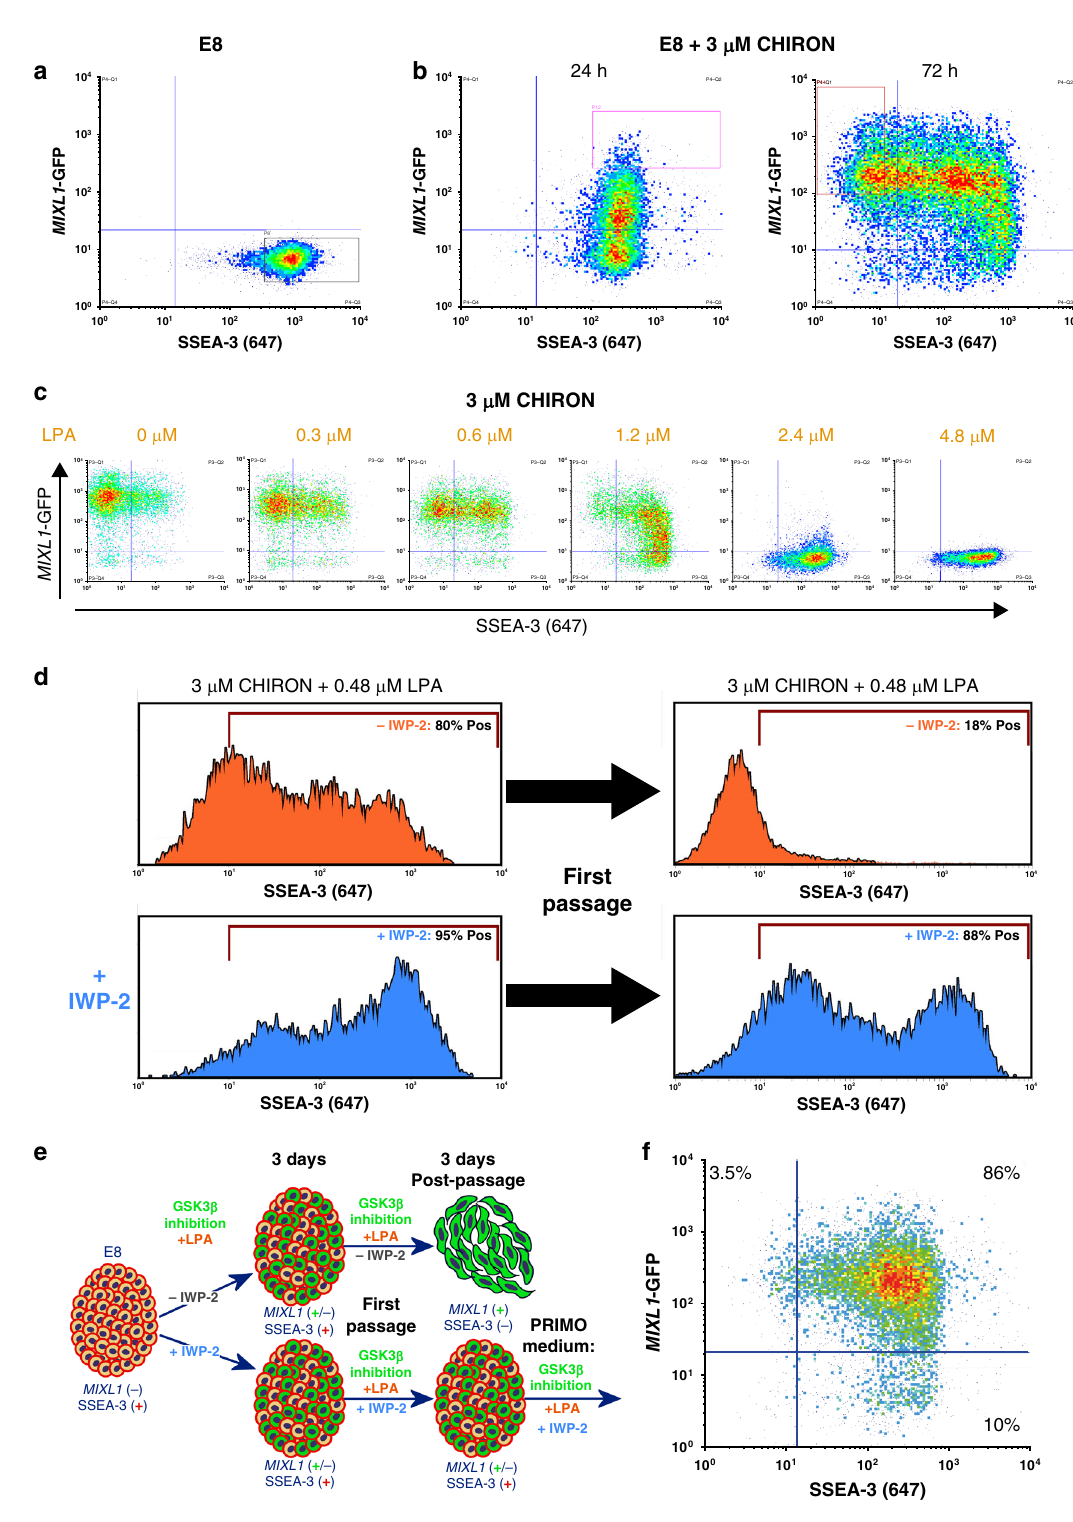
and SSEA-3 expression (Fig. 4c, Supplementary Fig. S8). Over this period the expression of MIXL1 gradually increased, preceding the eventual loss of SSEA-3 expression. Bulk RNAseq data from the emerging cells at each time point was compared by PCA with RNAseq data from MIXL1- GFP( − )/SSEA-3( + ) and MIXL1- GFP ( + )/SSEA-3( + ) cells growing in PRIMO conditions for 3 days (Fig. 4d). The MIXL1- GFP( + )/SSEA-3( + ) fraction mapped between 24 and 48 h, whereas the MIXL1- GFP( − )/SSEA-3( + )